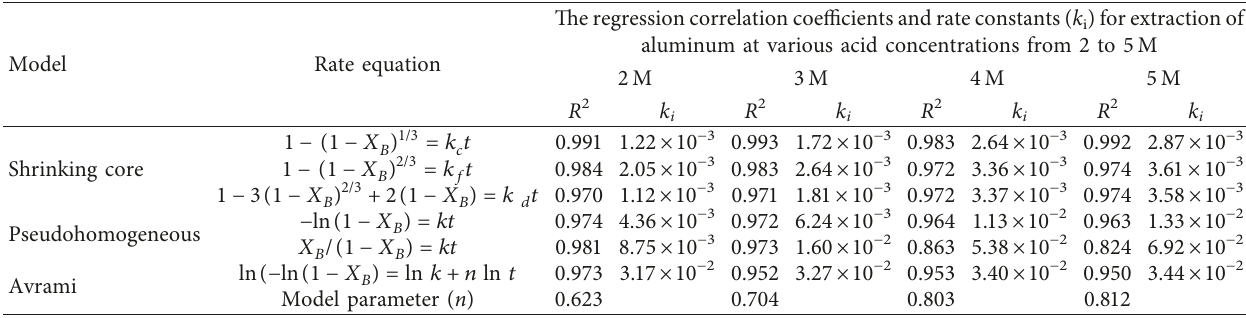
Table 2: The regression correlation coefficients and rate constants for extraction of aluminum at various acid concentrations from 2 to 5M. The regression correlation coefficients and rate constants ( k i ) for extraction of aluminum at various acid concentrations from 2 to Model Rate equation